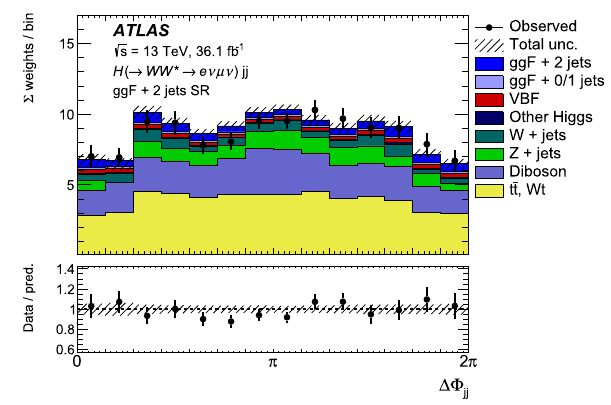
Fig. 4 The weighted (cid:10)(cid:11) jj post-fit distribution in the ggF + 2 jets sig- nalregion,withsignalandbackgroundyieldsfixedfromthefittotan (α) using shape and rate information. Data-to-simulation ratios are shown at the bottom of the plot. The shaded areas depict the total